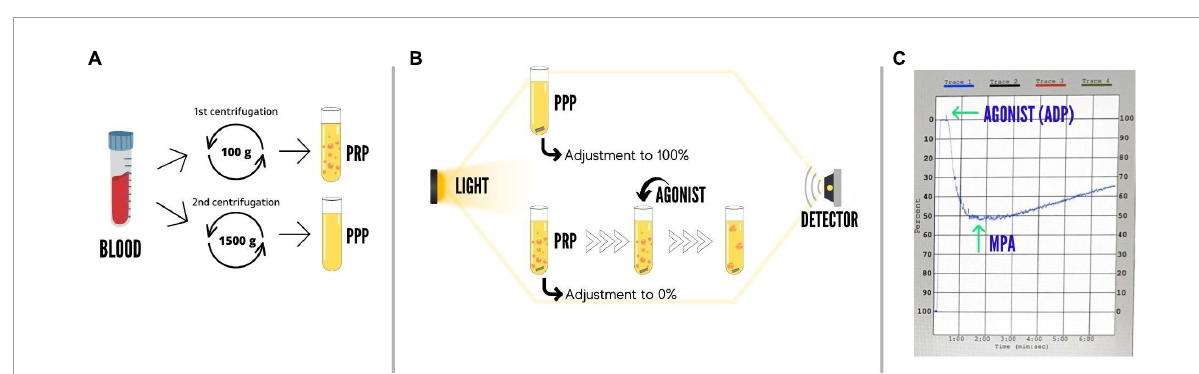
FIGURE2 Schematic representation of the light transmission aggregometry assay. (A) Sample preparation. Platelet-rich plasma (PRP) is obtained as a supernatant after centrifugation of citrated blood at 100 g for 10 min; afterward, platelet-poor plasma (PPP) is obtained by a second centrifugation of the blood fraction at 1500 g for 15 min. (B) Methodology. In the aggregometer, light transmission is adjusted to 0% for PRP and to 100% for PPP for each measurement; during light transmission aggregometry, samples are constantly stirred at 1000 rpm; the addition of